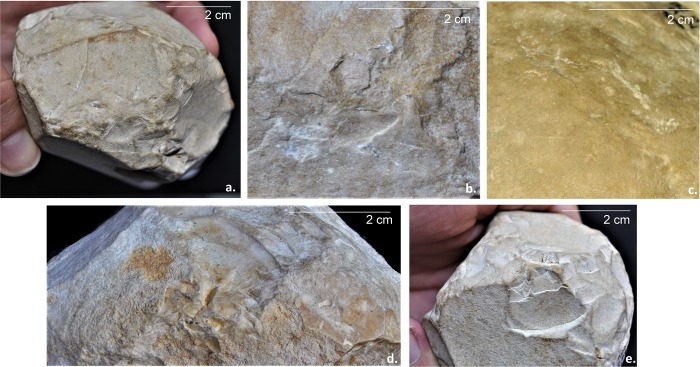
Percussion marks on the analyzed tool sample.a.) Micro-removals; b.) Surface scarring; c.) Cupola; d.) Accidental removal negatives; e.) Facetted breakage.